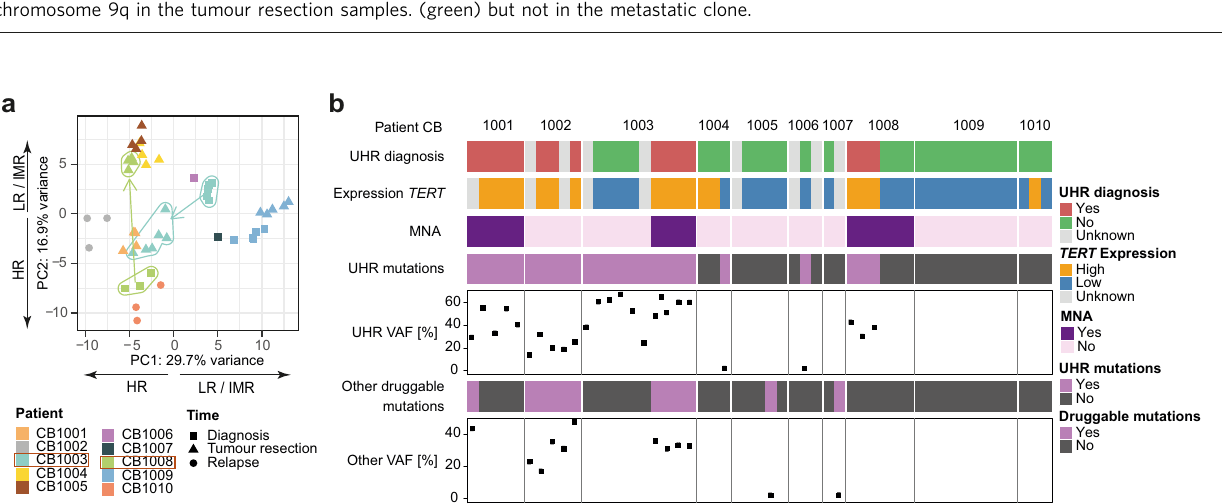
Fig. 5 Impact of temporal and spatial intratumour heterogeneity on gene expression, ultra-high-risk strati fi cation and putative therapy options. a RNA sequencing was used to analyse gene expression in 48 spatially and temporally distinct samples from a cohort of 10 patients. Principal component analysis (PCA) was conducted for risk-associated gene expression in the 48 samples. Legend describes patient number and sampling time. Arrows within the plot indicate samples from patients CB1003 and CB1008 collected at different time points during the disease. Arrows adjacent to the axis annotate high-risk and low-risk/intermediate-risk neuroblastomas. b Molecular classi fi cation of ultra-high risk (UHR) for the patient (termed UHR diagnosis here) was performed for each tumour sample separately using TERT mRNA expression, MYCN copy number and mutations (WES) in the TP53 and RAS/MAPK pathways. Variant allele frequency (VAF) is given for all mutations as % of reads that support the mutation. Mutations in the TP53/RAS/MAPK pathways with a VAF > 5% were de fi ned as UHR mutations. Other druggable mutations based on the INFORM criteria 8 are shown for each sample. TERT expression was de fi ned as “ high ” according to Ackermann et al. 3